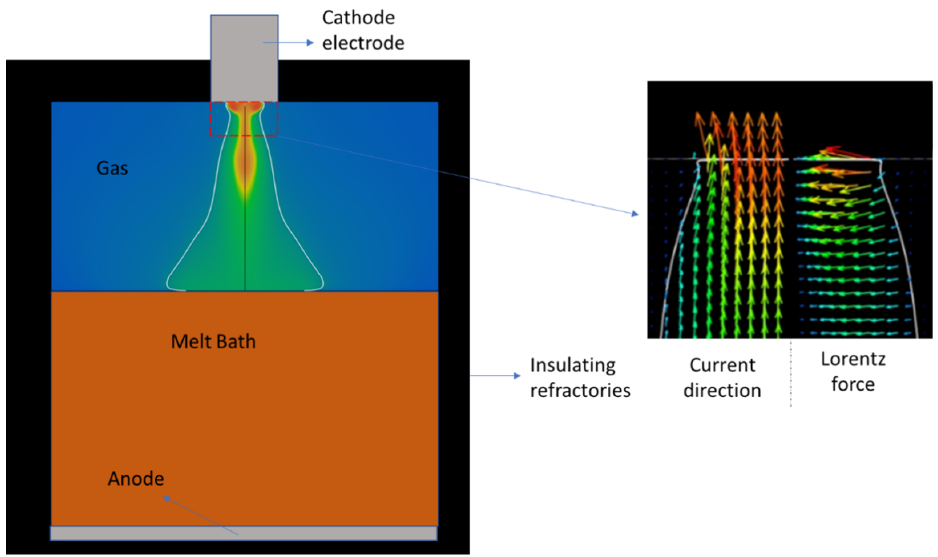
Figure 1 . Electric arc furnace schematic. Figure 1. Electric arc furnace